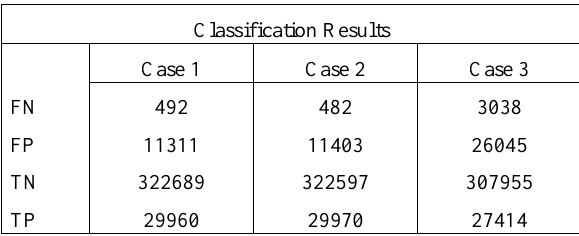
Table 3. Summary table of False Negative (FN), False Positive